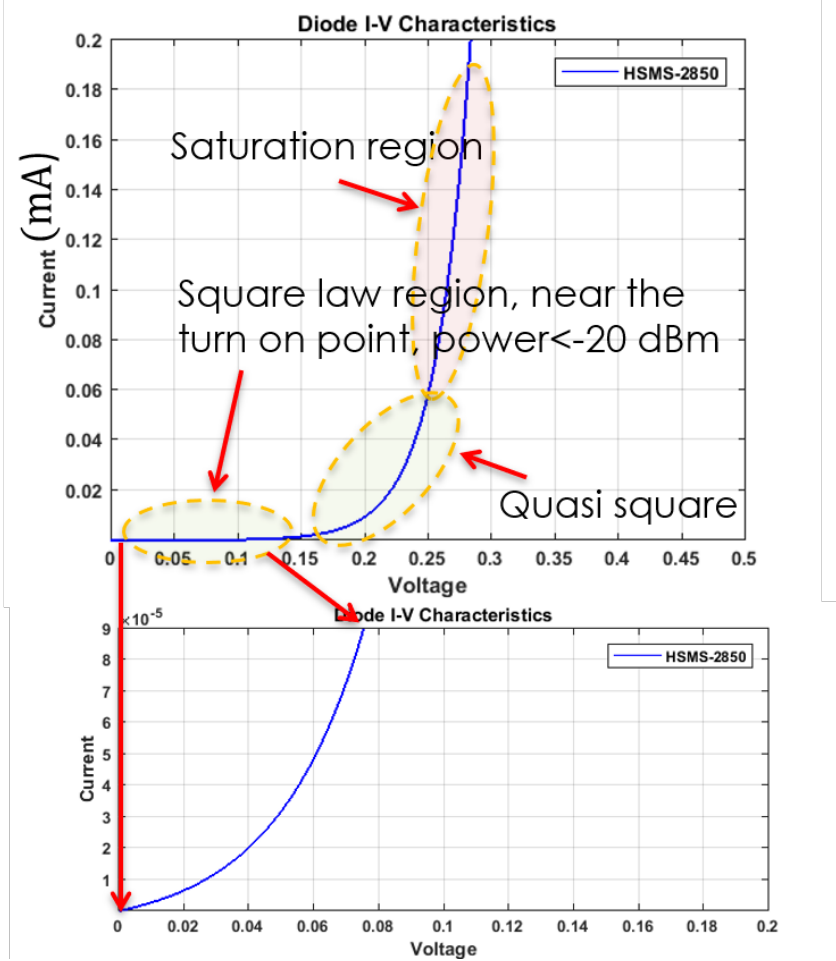
Figure 9. Utilized diode I–V